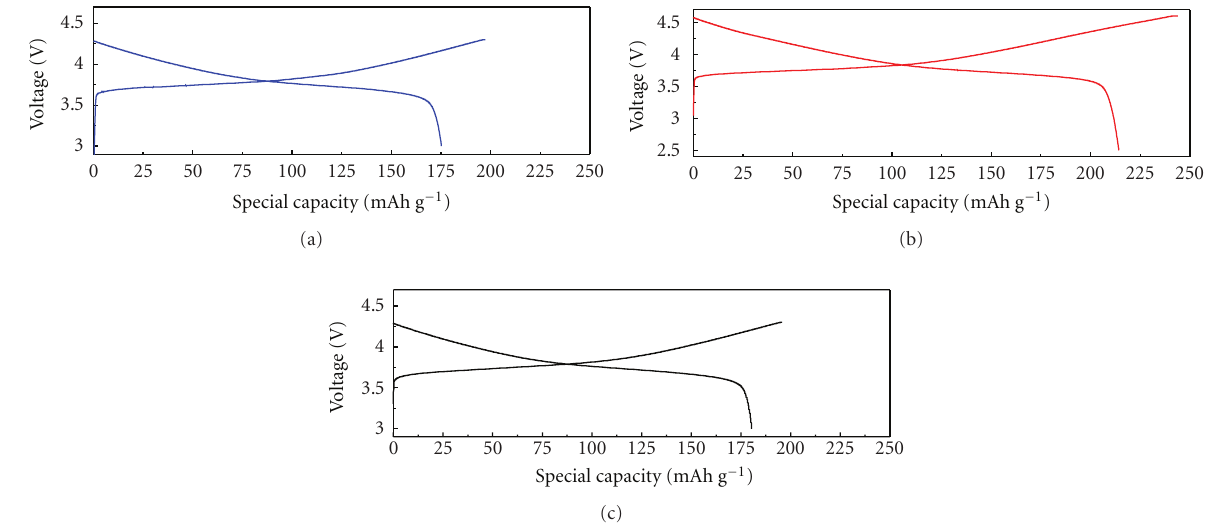
Figure 8: Initial charge and discharge profiles of Li/Li[Ni 0 . 5 Mn 0 . 3 Co 0 . 2 ]O 2 cell at a current density of 0.2 C rate under di ff erent limiting